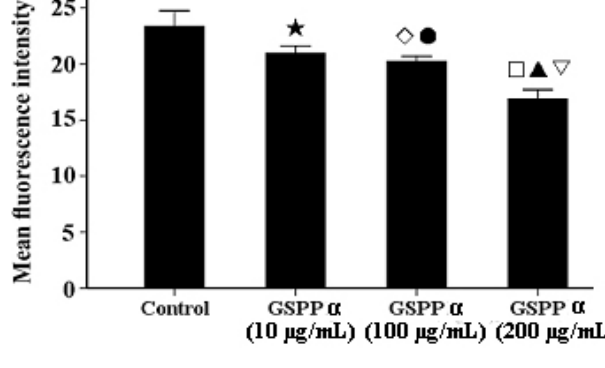
Figure 7. Effect of Gekko sulfated glycopeptides on the intracellular calcium concentration in SMMC-7721 cells. Cells were incubated with the Fluo-3 AMester and analyzed by fl ow cytometry. The values represent means ± SD. ★ versus control group, P = 0.011; ◇ versus control group, P = 0.003; ● versus 200 µg/mL GSPP α , P = 0.002; □ versus control group, P < 0.001; ▲ versus 10 µg/mL GSPP α , P = 0.001; ▽ versus 100